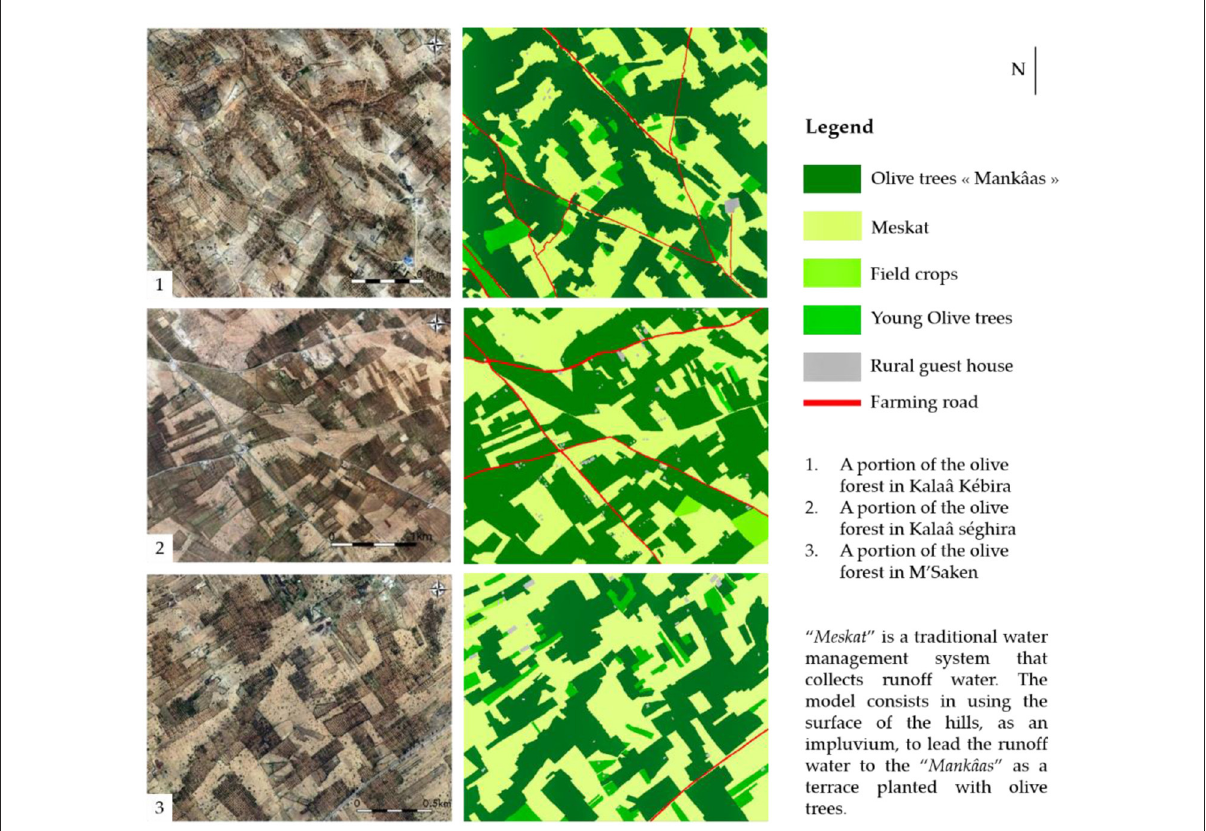
FIGURE4 Land uses in PALA “Ghaba” (partial images of the olive groves in Kalaâ Kébira, Kalaâ Sghira, and M’Saken). Own source.